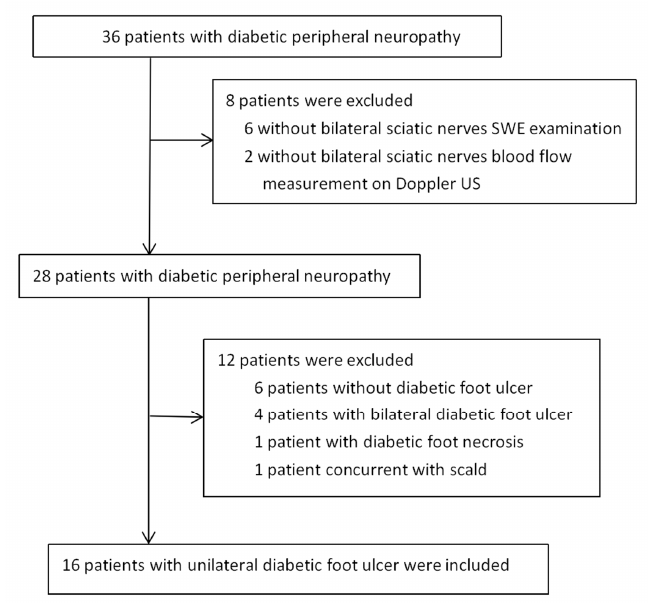
Figure 1. Flowchart of the process for selecting patients with unilateral diabetic foot ulcer. Of those 16 patients with DPN, 15 patients were diagnosed by both electromyogram